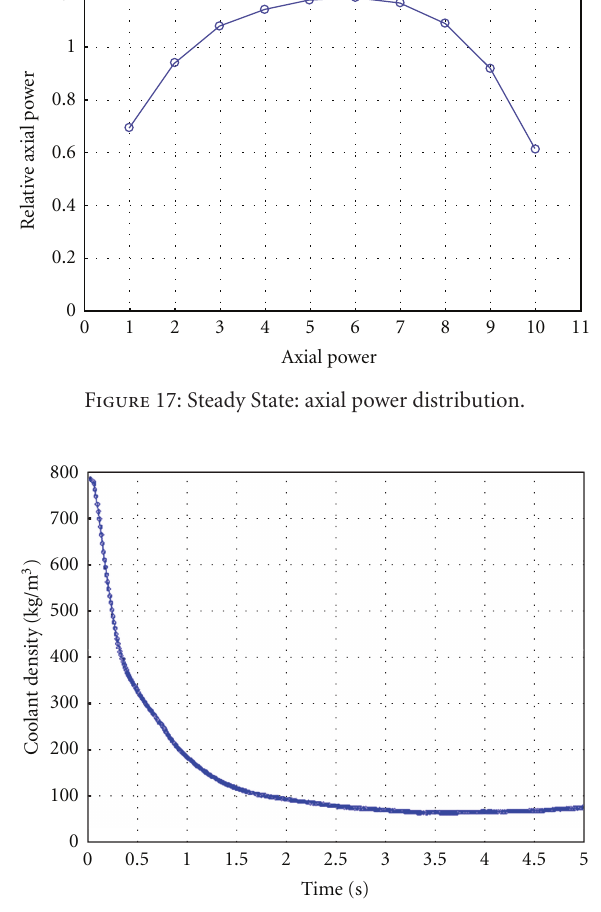
Figure 18: Transient: coolant density versus